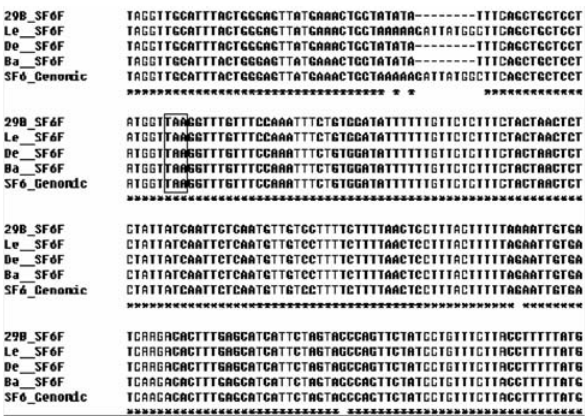
rieties. Identical nucleotides are marked with asterisks (*) while mutated nucleotides are blank. The rectangle indicates the TAA stop